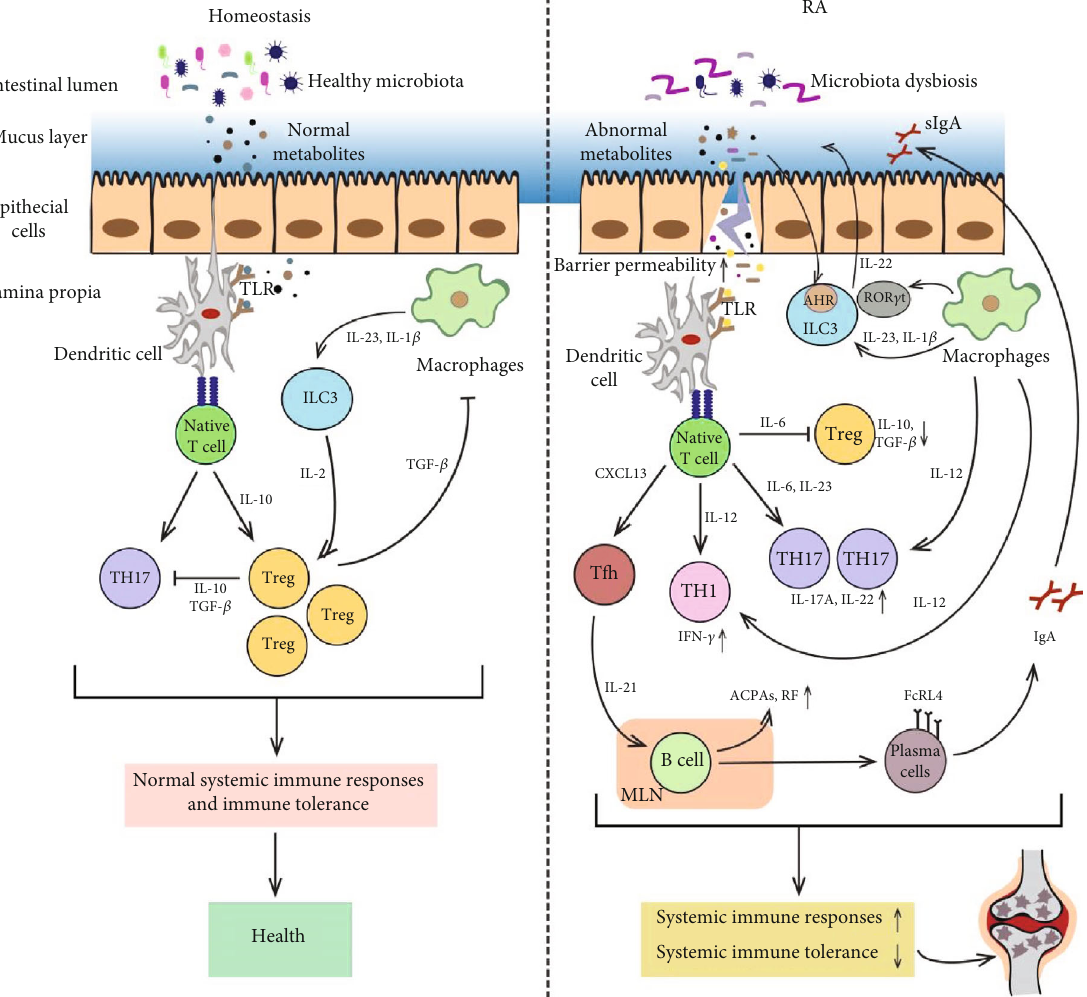
Figure 1: Gut microbiota dysbiosis contributes to the pathogenesis of RA, and a variety of ICs act as a bridge linking the gut microbiota and RA via multiple molecular mechanisms. The healthy gut microbiota and their normal metabolites maintain the integrity of the intestinal epithelial cell layer and the homeostasis of gut